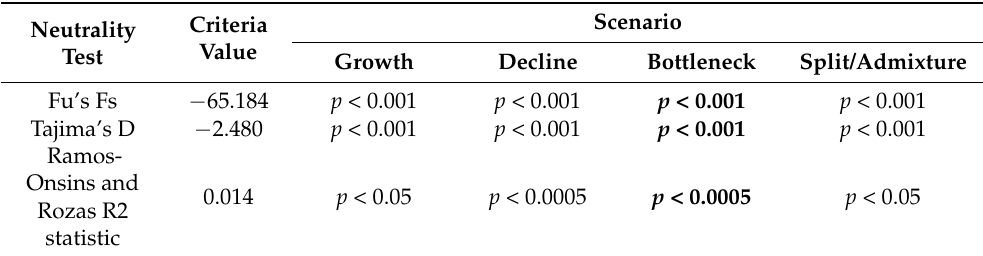
Table 3. The significance of Fu’s, Tajima’s, and Ramos-Onsins and Rozas’s neutrality tests used in coalescent-based simulation: probabilities of the most appropriate scenario are in